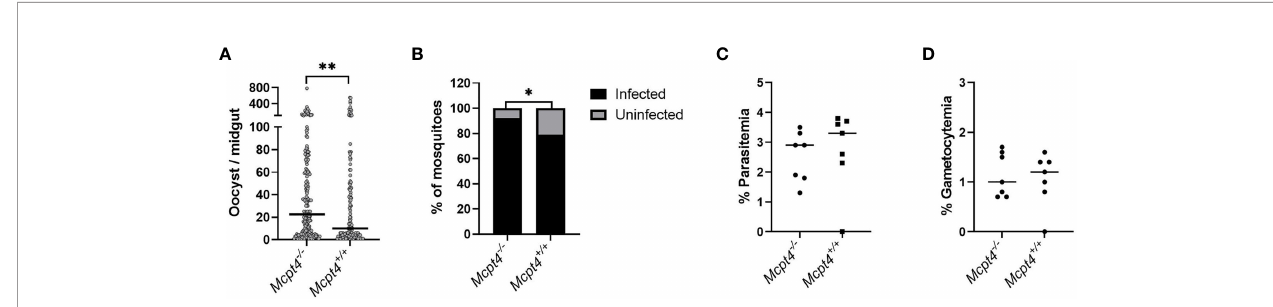
FIGURE 8 | Transmission of P. y. yoelii 17XNL from infected Mcpt4 -/- and Mcpt4 +/+ mice to Anopheles stephensi . Panels (A, B) , respectively, represent the numbers of oocysts per midgut and proportions of infected mosquitoes in three independent biological replicates. Panels (C, D) , respectively, illustrate the percentages of mouse erythrocytes infected with asexual stage P. y. yoelii 17XNL and sexual stage gametocytes on the day of mosquito infection (day 3 PI). Parasite transmission was determined in three biological replicates (n=7 mice per group, 30 fed mosquitoes per mouse). The numbers of midgut oocysts in mosquitoes fed on Mcpt4 -/- and Mcpt4 +/+ infected mice were analyzed by Mann Whitney test. The percentages of infected mosquitoes (mosquitoes with zero oocysts excluded) were analyzed with Fisher ’ s exact test. Parasitemia and gametocytemia data were analyzed using unpaired t tests. P values ≤ 0.05 were considered signi fi cant. *P ≤ 0.05, **P ≤